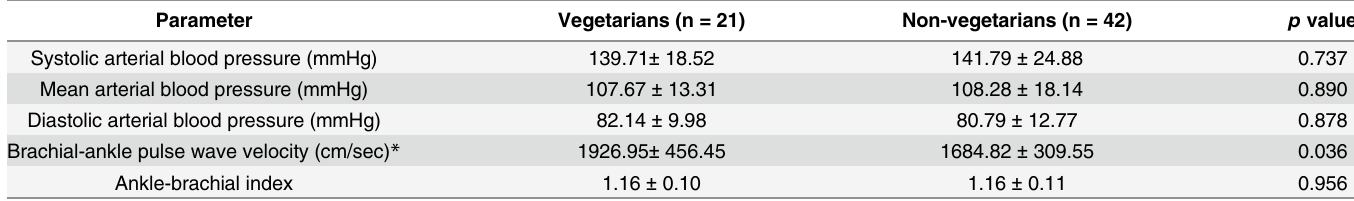
In the present study, the vegetarian group had significantly lower serum BUN, creatinine, phosphate, calcium × phosphate, uric acid, albumin, and nPCR levels compared with the non- vegetarian group. The nPCR, known as the protein equivalent of nitrogen appearance, is an indicator of protein catabolism and appropriately reflects dietary protein intake in a steady condition. Albumin can serve as indicator of visceral protein storage. These markers showed that vegetarian diets include lower protein intake than non-vegetarian diets. All data generated in this study, including 24-hour dietary record analyses, support the hypothesis that usual Tai- wanese vegetarian diets have lower protein content and decreased nitrogen load, resulting in lower BUN, phosphate, and serum uric acid levels. These findings were compatible with those from a previous study [19]. Table 4. Comparison of index of artery stiffness between vegetarian and non-vegetarian groups.